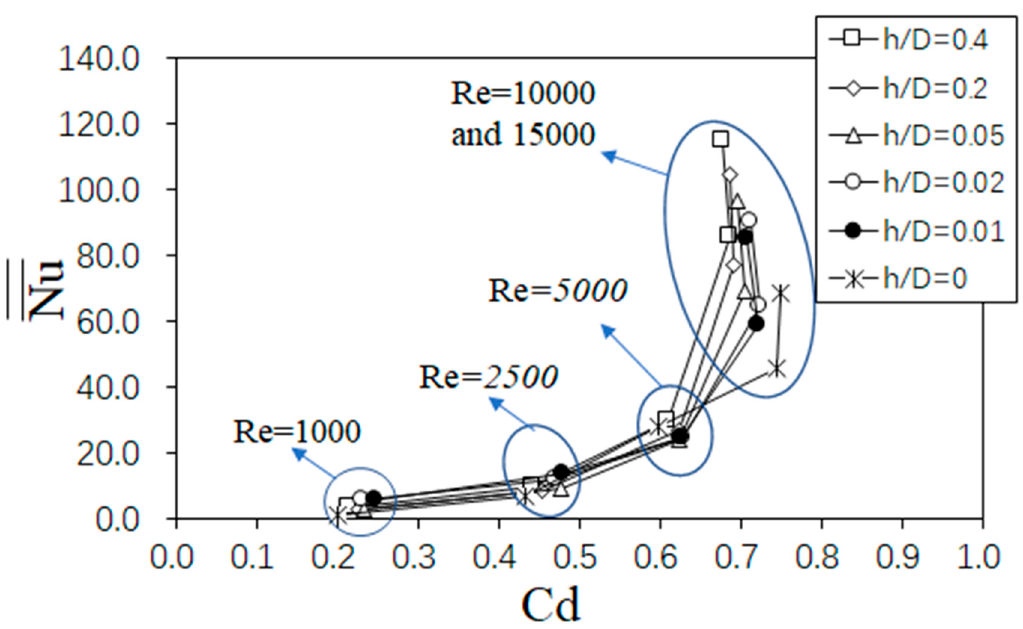
Figure 21. Spatially averaged Nusselt number as dependent upon C d , for different micro cooling unit heights, and different Re j .